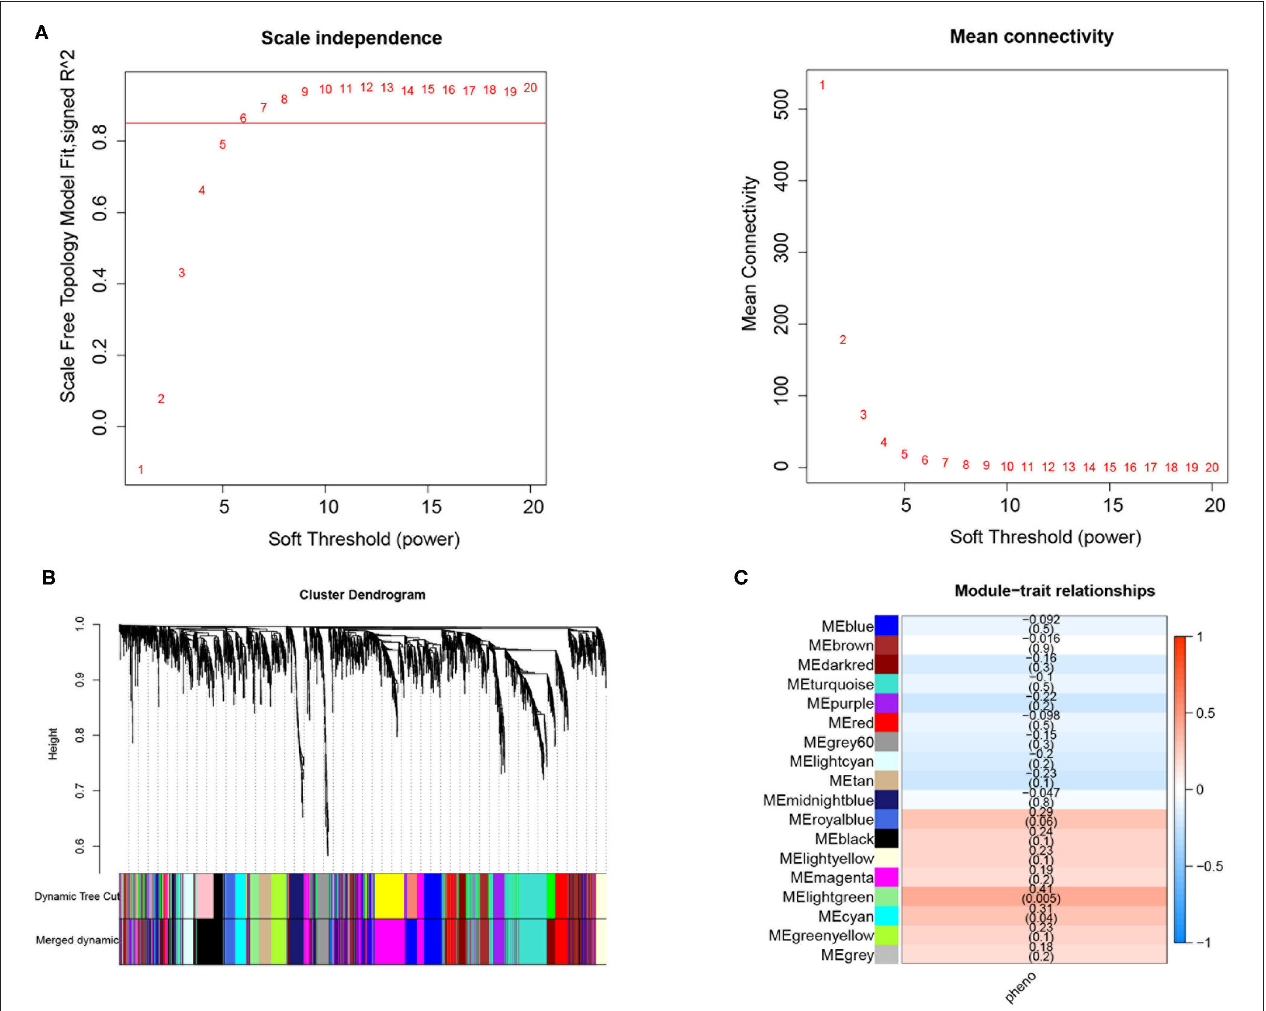
FIGURE 1 | Weighted correlation network analysis to obtained the module associated with the development of diabetes mellitus-related atherogenesis in 33 healthy control samples, 15 DM samples and 15 DMCHD samples. (A) Graphical representation showing the selection of soft-thresholding powers. (B) Hierarchical clustering dendogram. (C) Histogram showing module-trait correlations. Light green module was the modules which had the strongest correlation with diabetes mellitus-related atherogenesis. DM, diabetes mellitus. DMCHD, diabetes mellitus-induced coronary heart